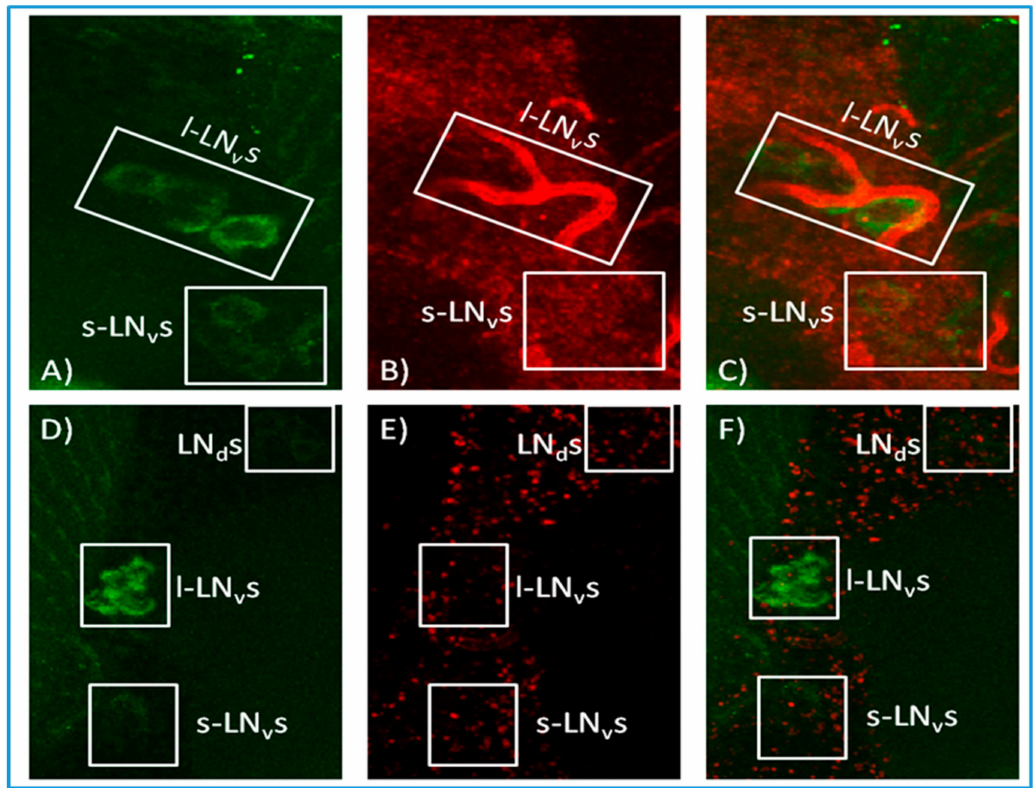
Figure 2. In situ hybridisation. Ventral views of representative R32 adult brains probed with α -LACZ antibody (( A , D ), green), antisense norpA probe (concentrated 75 ng, ( B ), red)—the bright red staining around the PDF cells may represent trachea, and sense norpA probe (concentrated 150 ng, ( E ), red). ( C ) and ( F ) are a merge of ( A , B ) and ( D , E ), respectively. The brains presented are images of 10 independent layers merged